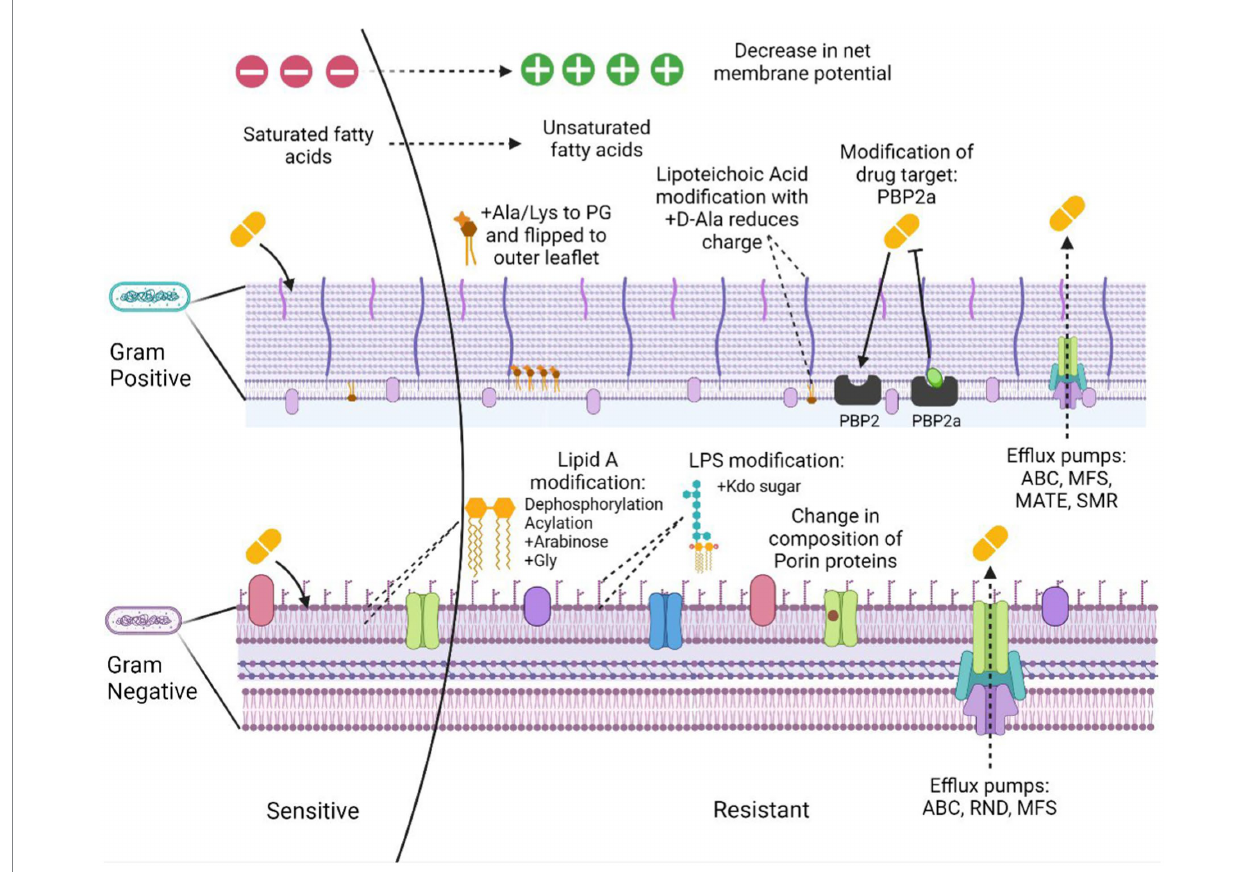
FIGURE 1 Mechanisms of membrane-based drug resistance in Gram positive and Gram negative bacteria. Figure created in